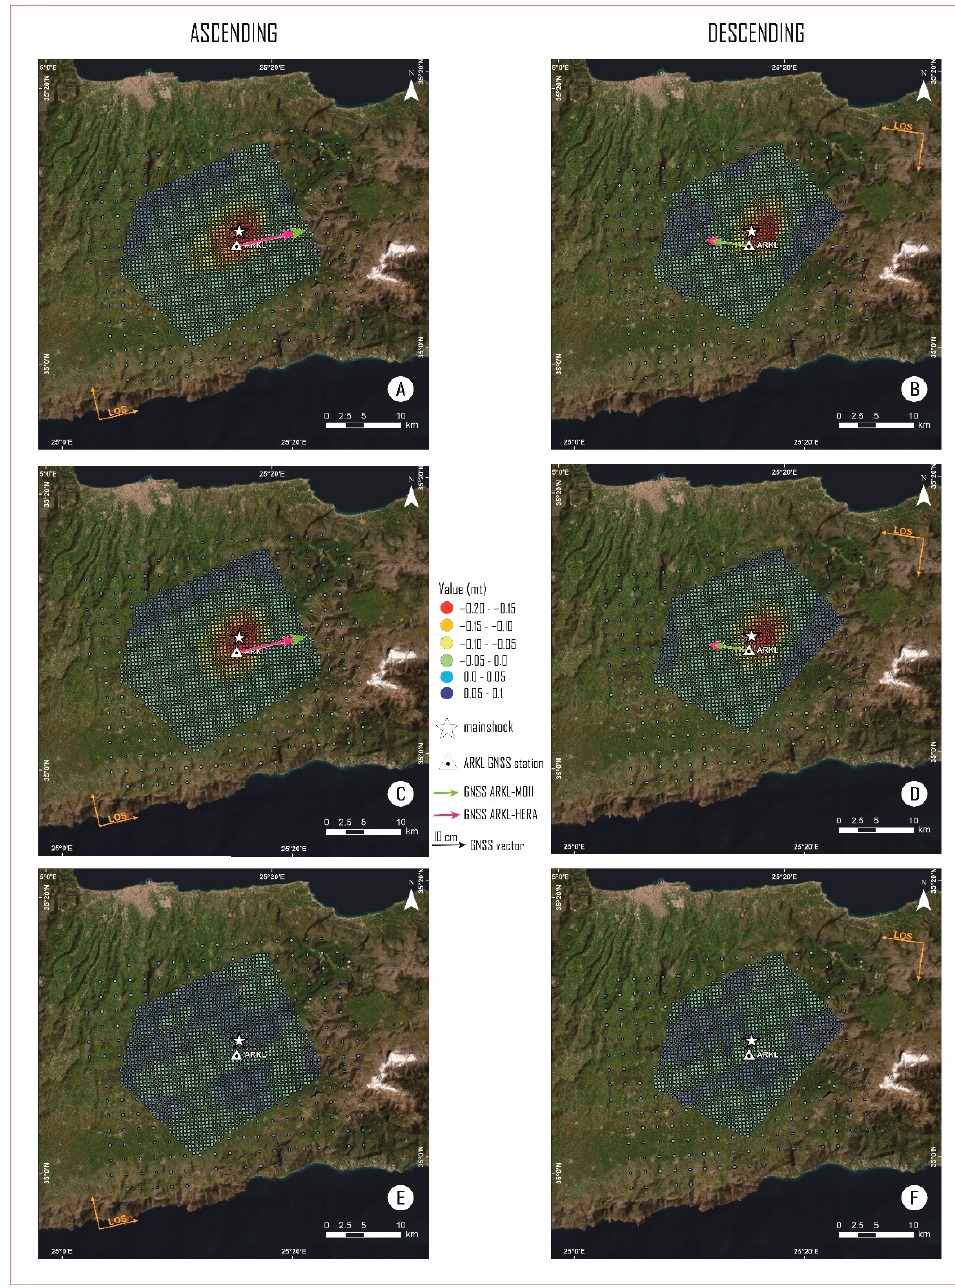
Figure 9. Observed ( A , B ), modelled ( C , D ) and residual ( E , F ) maps for displacement obtained from both pairs. The colored arrows represent the displacement vectors of the GNSS, observed and modeled, along the Line Of Sight (LOS) of the satellite. The white star shows the location of mainshock. The white triangle indicates the position of the ARKL GNSS station.